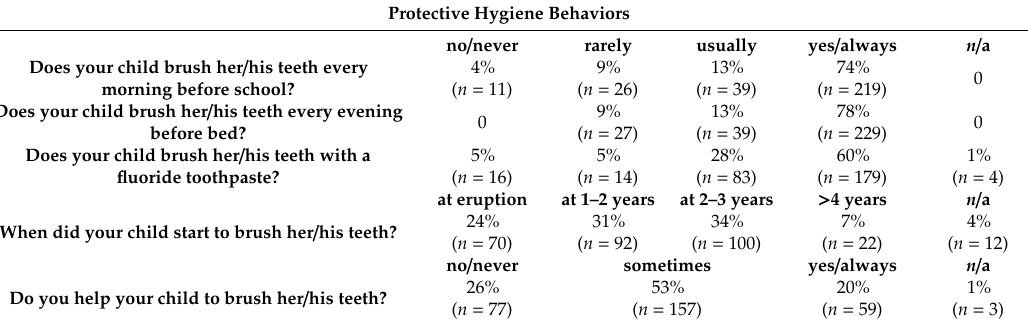
Table 2. Questions and data on protective hygiene behaviors.